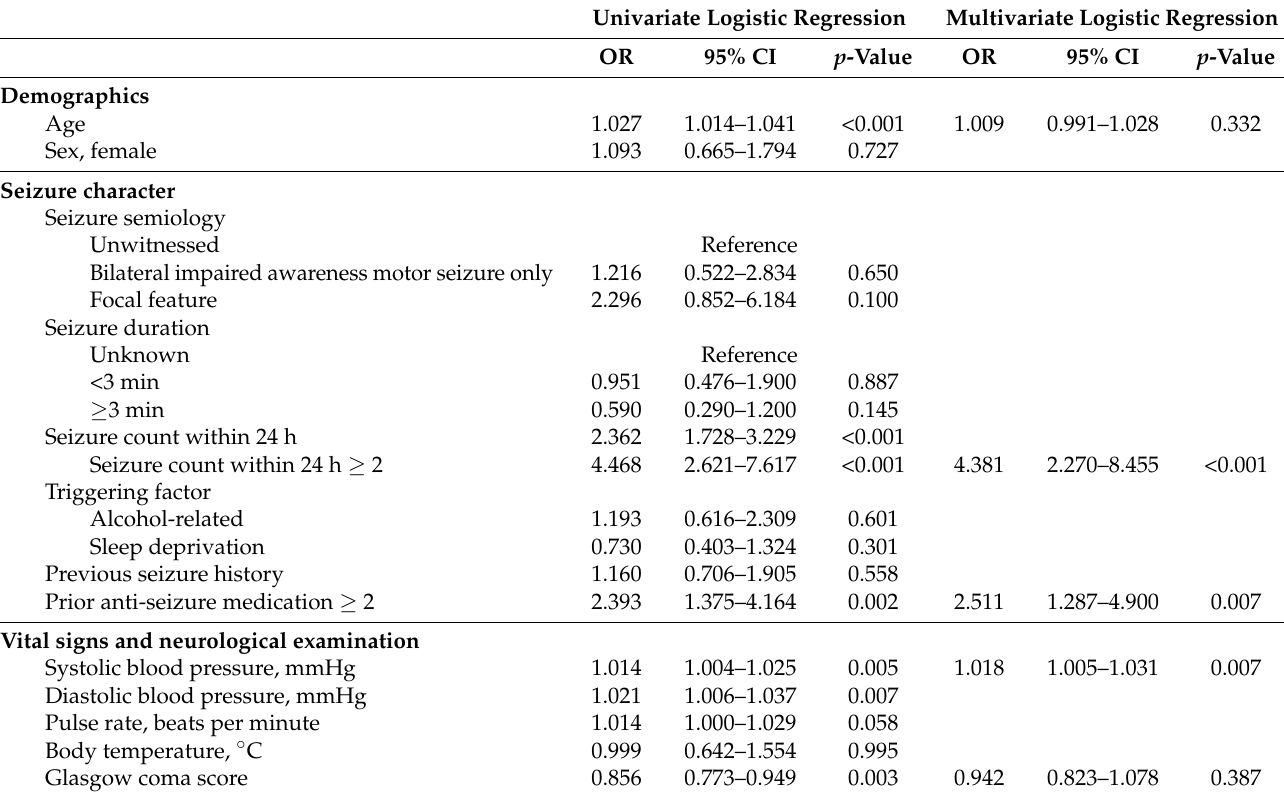
Table 2. Logistic regression analyses of variables associated with ES-RED in the derivation